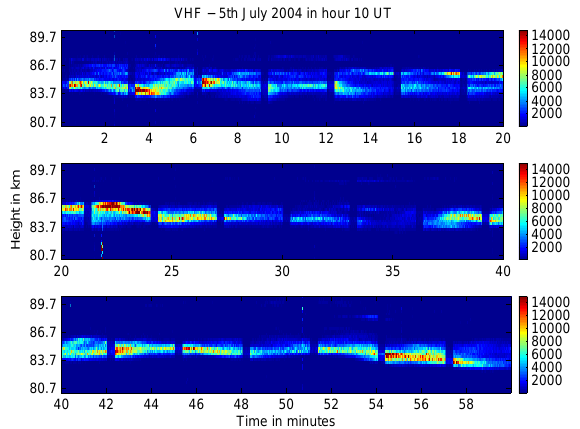
Fig. 7. One hour of raw data. The heater transmitter is now run at full power in all cycles. The overshoot cycles are each 3m long and the heater is on for 20s. This is clearly shown as a reduced intensity with 3m interval, lasting for 20s, followed in most cases by strong overshoots.